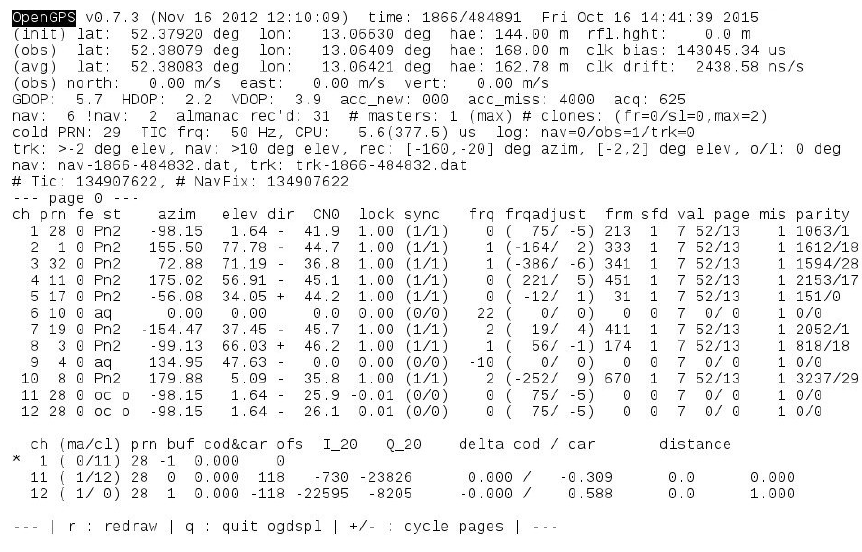
Figure A2. Screenshot of a terminal window running the OpenGPS user space application ogdspl . In the lower half characteristic infor- mation on the 12 tracking channels is shown. Note that ogdspl maps azimuth angles to the interval [− 180 , + 180 ◦ ] with − 90 and + 90 ◦ referring to west and east, respectively. At the time of the measurement on 16 October 2015 channel 1 tracked PRN 28 at an elevation angle of + 1 . 64 ◦ (column 6 entitled “elev”). Its azimuth value ( − 98 . 15 ◦ ) is within the selected observation window ( [− 160 , − 20 ◦ ] ) and the O/L channels A and B, here listed as channel 11 and 12, are cloned from channel 1. In-phase and quad-phase samples as well as parameters describing the alignment between master and clone channels are listed at the very bottom of the screen. The top few lines list position and clock solutions from to the real-time navigation